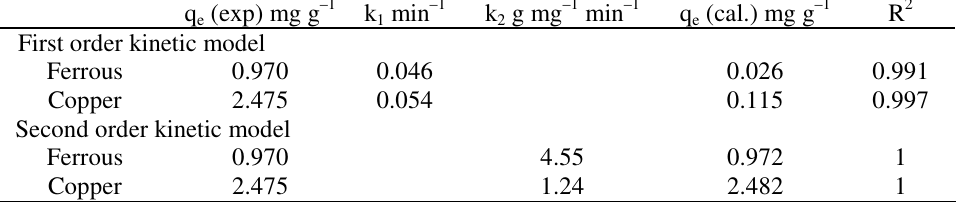
Figure 4 . Plot of time versus tq t–1 for adsorption of ferrous and copper ions onto pine fruit powder. Table 3 . Comparison of the first and second order adsorption rate constants and calculated and experimental q values for ferrous and copper e